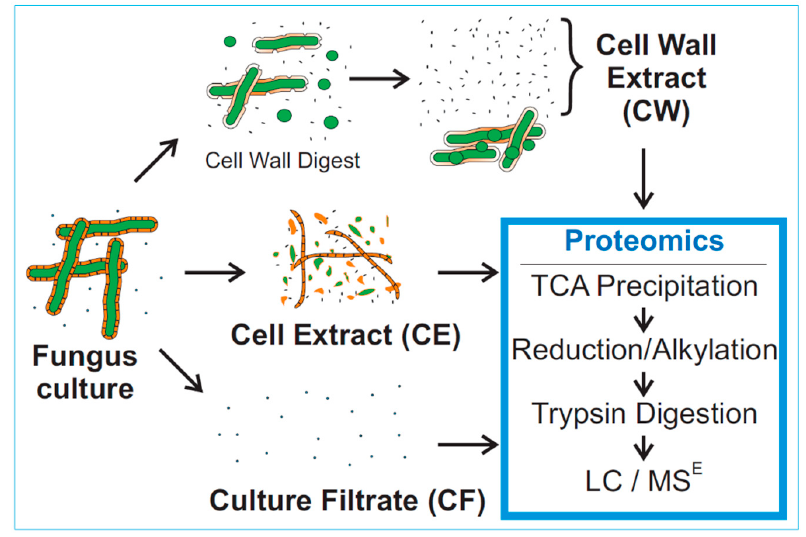
Figure 1. Workflow for generation of fungal protein fractions and processing for mass spectrometric analysis.